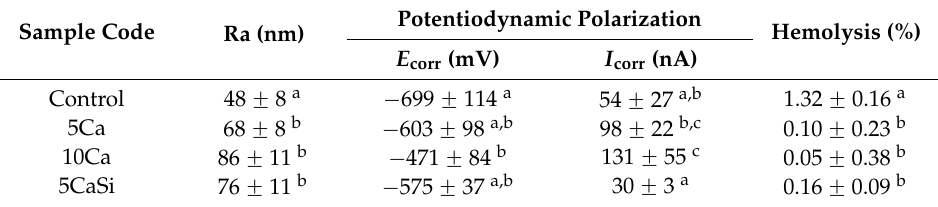
Figure 5. Surface SEM images of ( A ) Ti control, ( B ) 5Ca, ( C ) 10Ca and ( D ) 5CaSi groups. Table 1. Roughness (Ra), electrochemical parameters and hemolysis ratio of all samples.